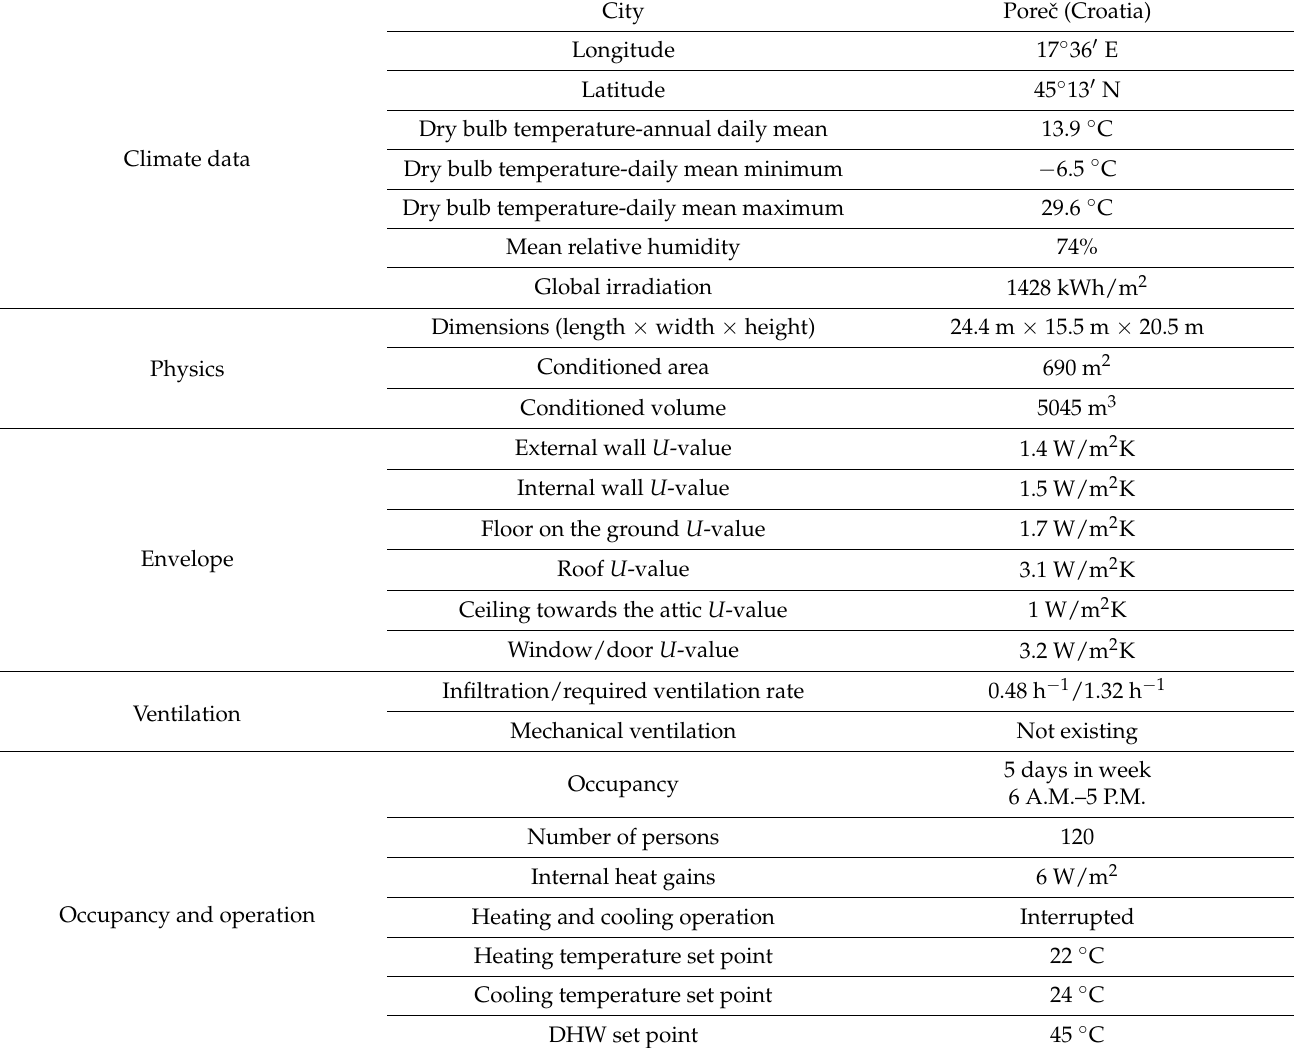
Table 1. Main characteristics of the building regarding physics, operation, and climate data.